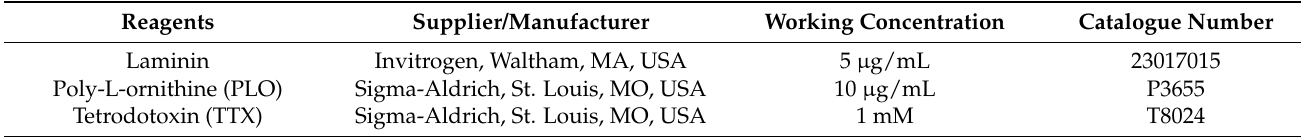
Table 9. List of reagents .